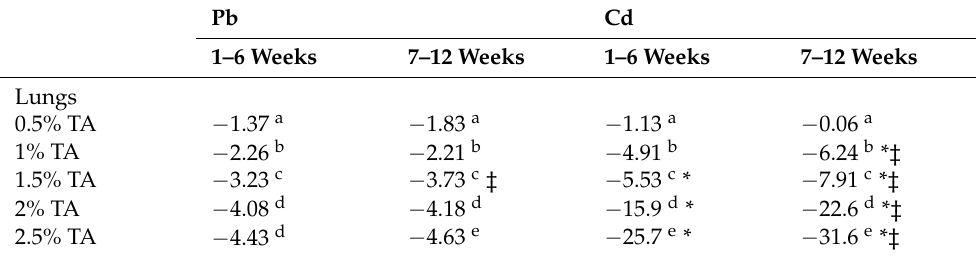
Table 5. Experiment 1—The degree of reduction in absorbing Pb and Cd in the lungs, heart and brain (for 6 and 12 weeks of exposure) compared with the 0% TA group,%. The value of 0% TA was assumed as 100%.